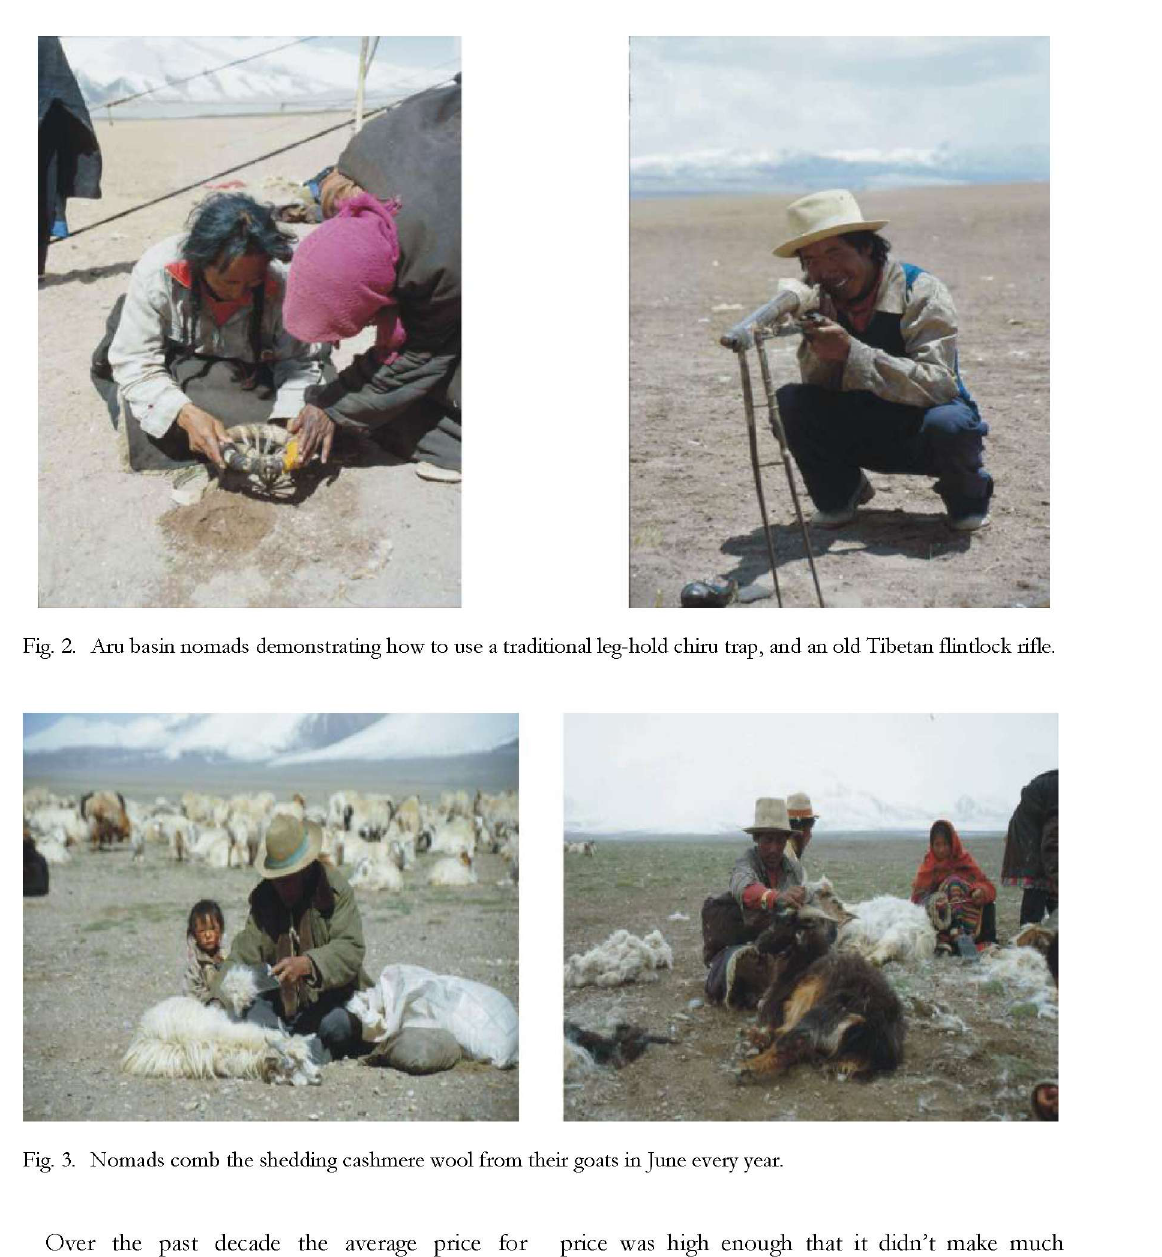
Fig. 3. Nomads comb the shedding cashmere wool from their goats in June every